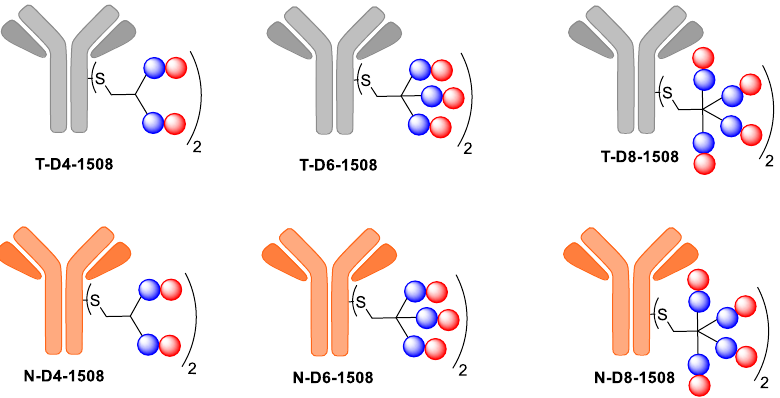
Figure 4. Schematic representation of trastuzumab- and NIP228-derived antibody–drug conjugates synthesized using linkers 1, 2 and 3 and cytotoxic payload AZ-1508.